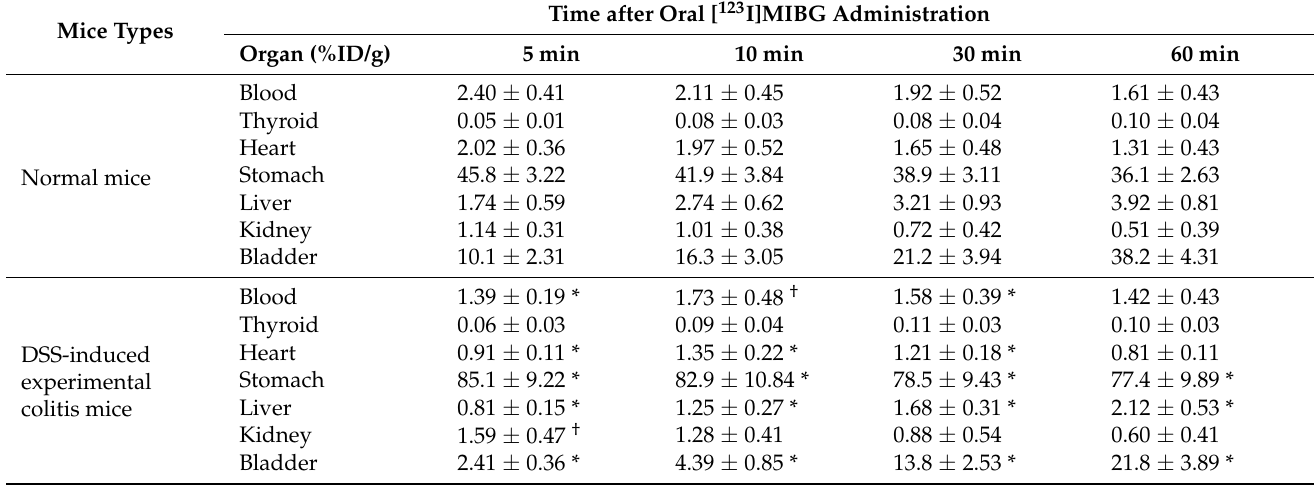
Table 1. Biodistribution of [ 123 I]MIBG-associated radioactivity following oral administration in normal mice, DSS-induced experimental colitis mice, and mice with oral cimetidine loading. Mice